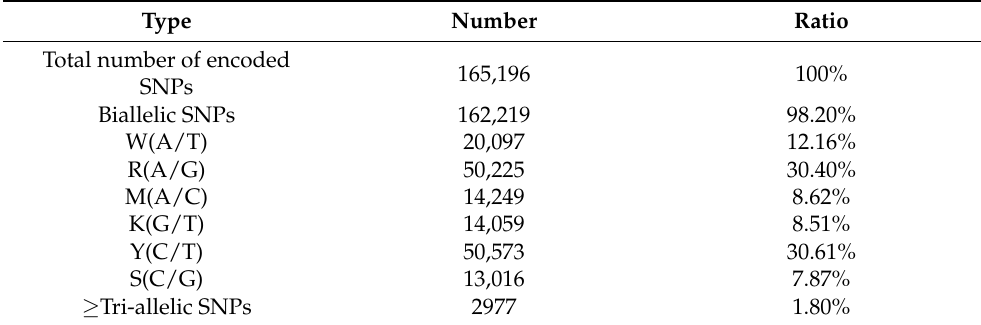
Table 4. Statistic of identified encoded SNP markers types.